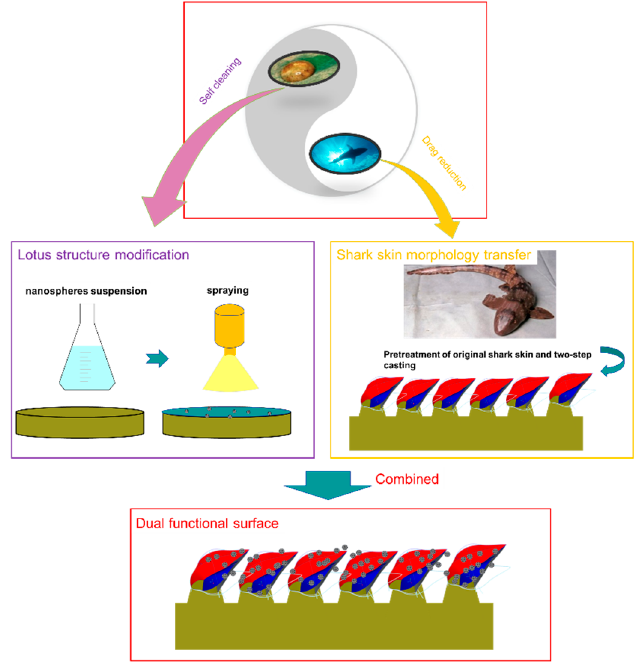
Figure 1. Process of synthetic replication of shark skin and lotus surface.